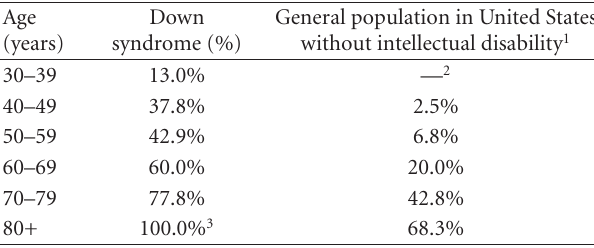
Table 2: Common ophthalmic findings and percentage prevalence. Table 3: Age-related prevalence of